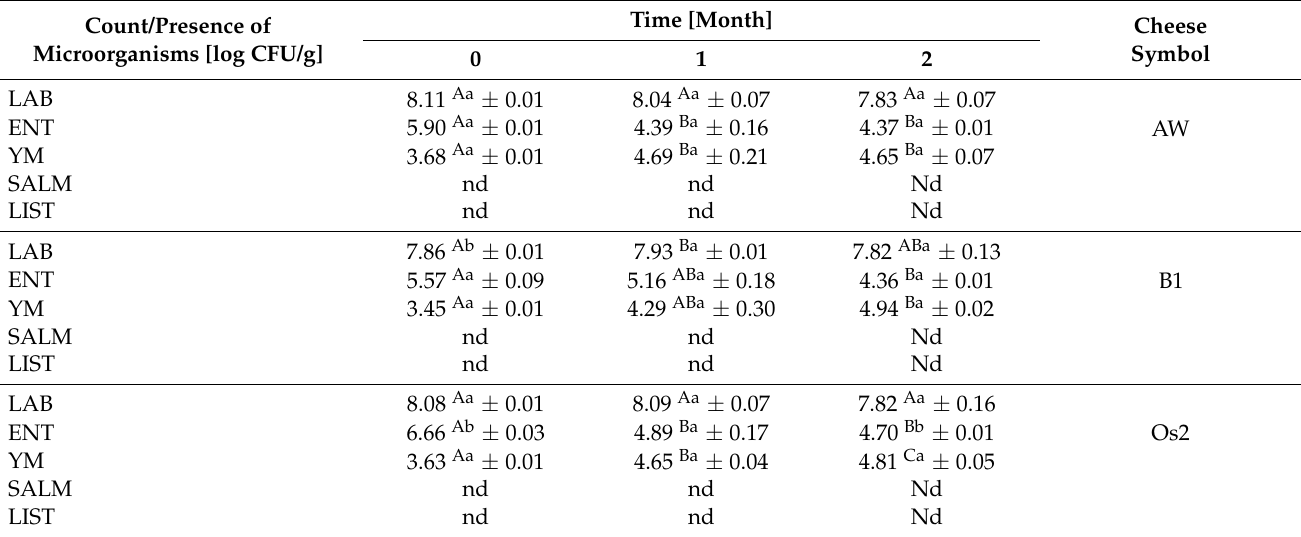
Table 1. Microbiological quality of the cheese samples during storage [log CFU/g].